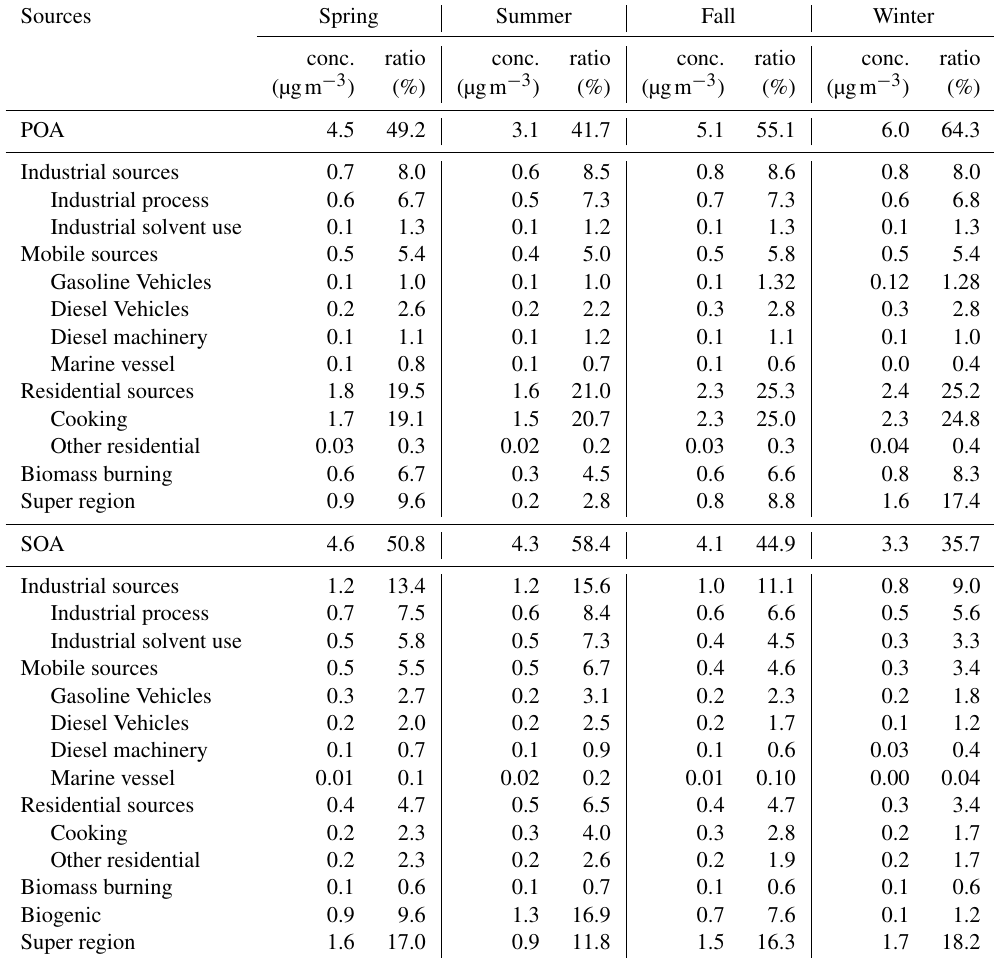
Table 3. POA and SOA source contributions of different emission sources in each season in the YRD region. Sources